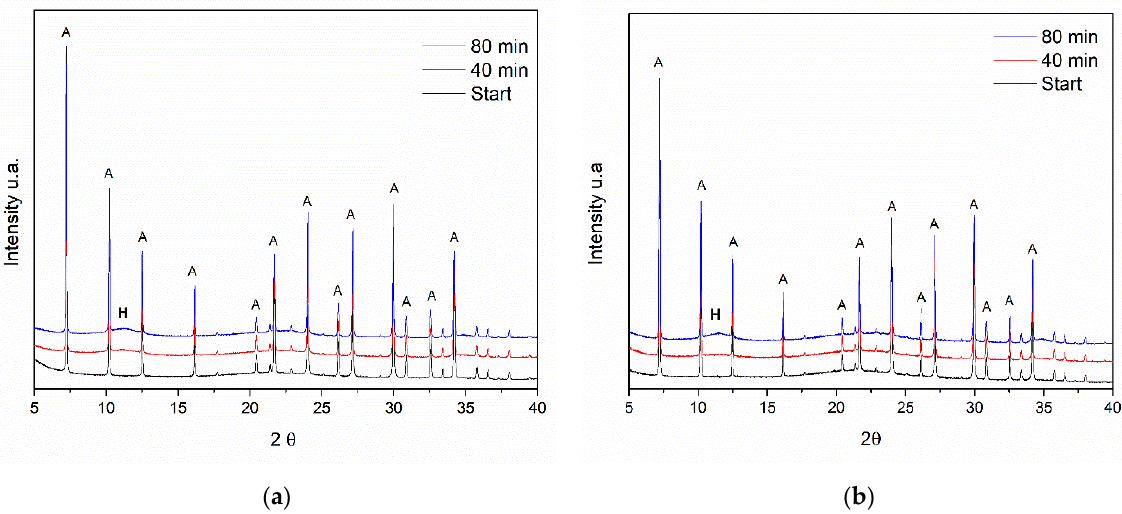
Figure 10. Diffractograms of the Al,Mg-LDH and zeolite A physical mixture rehydrated after ( a ) calcination under He flow and a temperature of 300 °C and ( b ) O 2 flow and a temperature of 500 °C. The symbol (A) indicates the reflections belonging to the zeolite A phase and (H) indicates the reflections referring to the hydrotalcite phase. The plane (003) characteristic of the LDH phase is also indicated in the rehydrated sample.